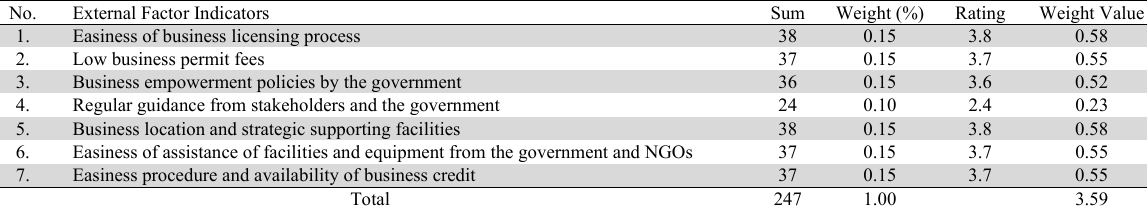
External Factor Analysis Summary (EFAS) of SMEs in Bali